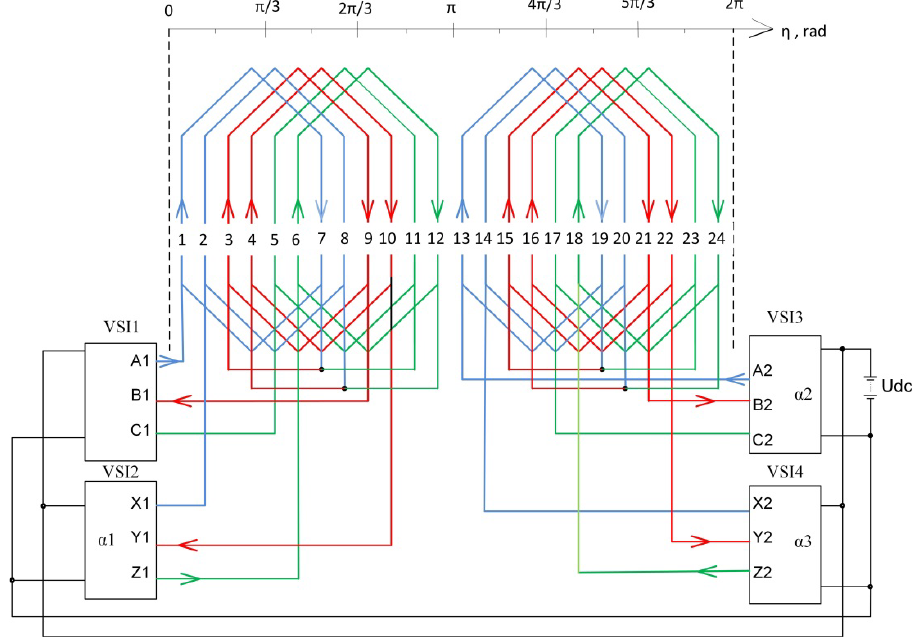
Figure 6. Block diagram of switch control-based pole-changing multi-winding IM. Such a multi-winding IM consists of two three-phase windings. Each winding consists of two sections shifted in space by 30 electric degrees, which are supplied from the VSI1, VSI2, VSI3, and VSI4